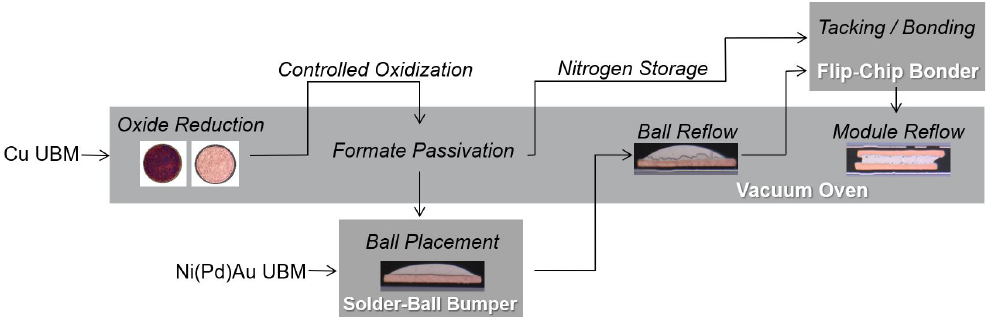
Figure 3. Bump-bond flow chart for chips with Ni(Pd)Au and Cu UBM. A single pad from a Cu80 sample is exemplarily shown in its initial oxidized, cleaned, bumped, ball-reflowed and final module-reflowed states for